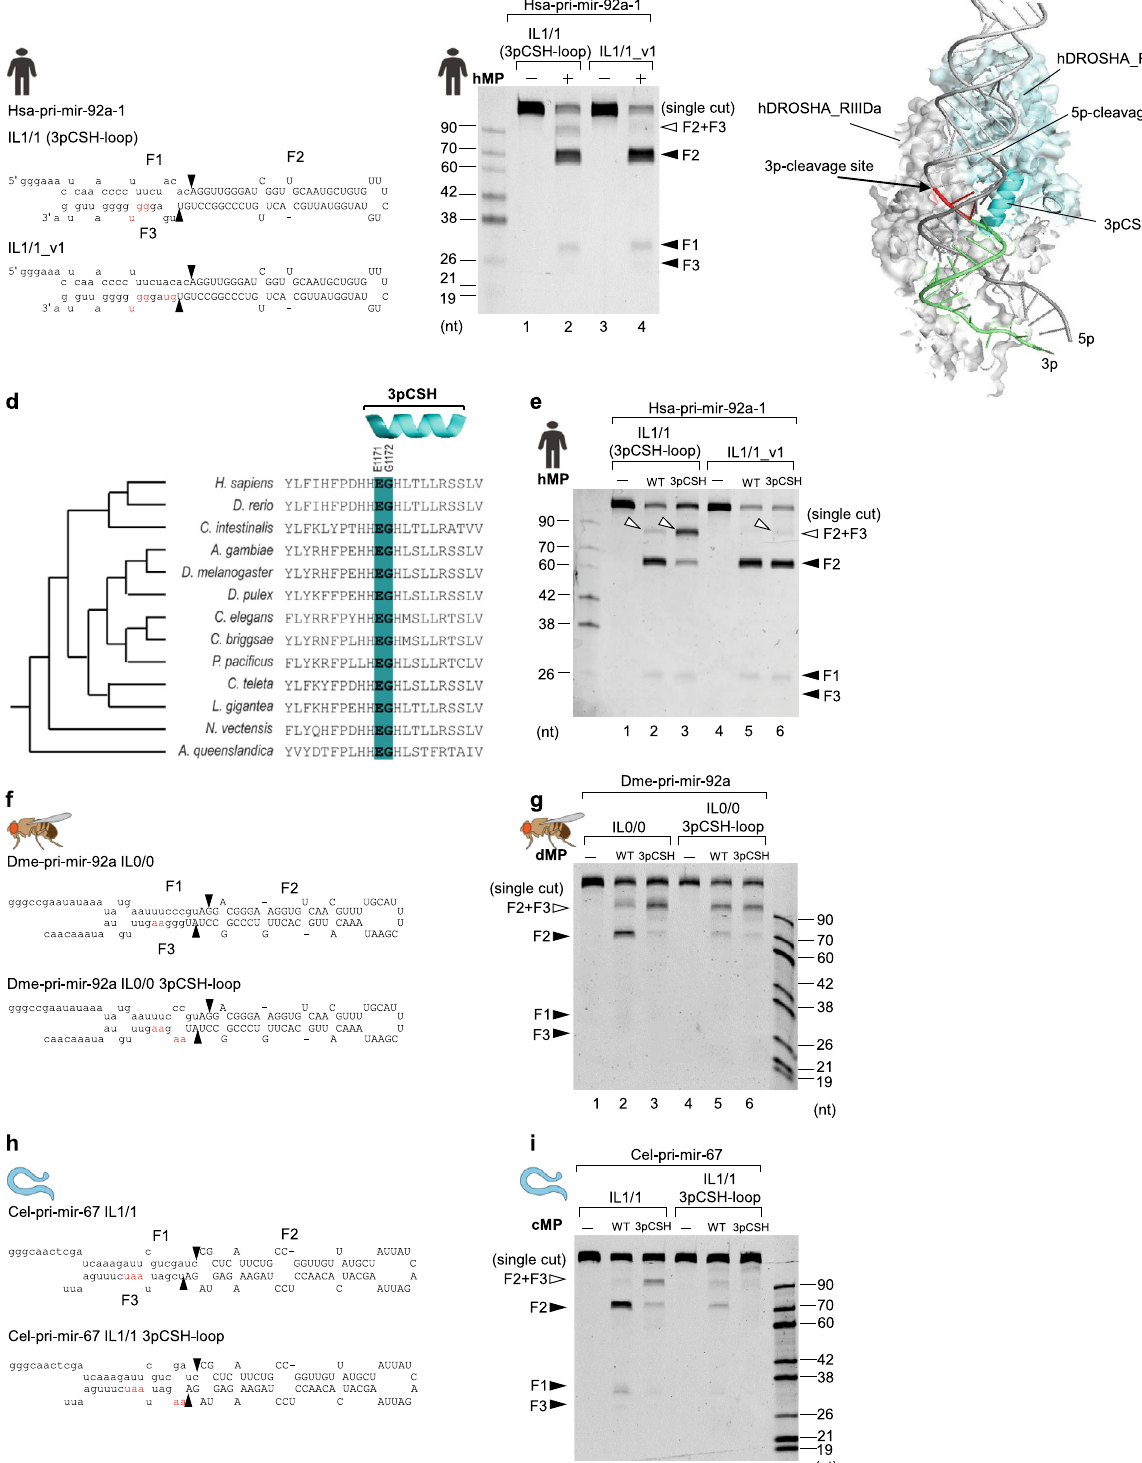
COMMUNICATIONS BIOLOGY| (2021) 4:1332